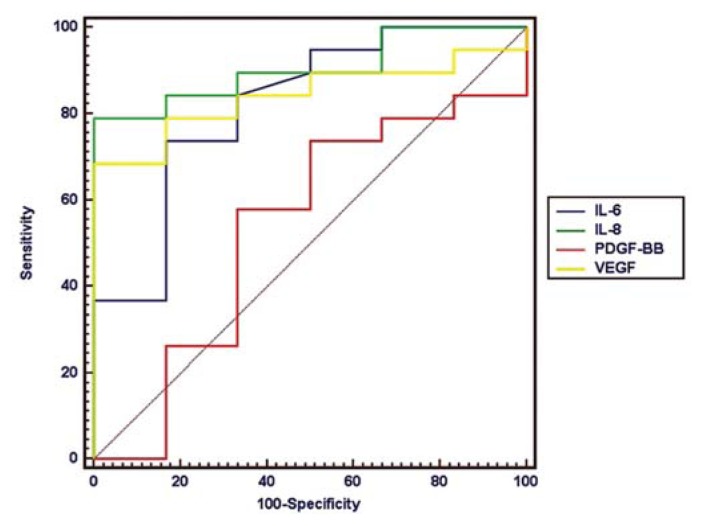
The diagnostic sensitivity and specificity of circulating angiogenic factors for HCC were assessed by receiver-operating characteristic (ROC) curves and the area under the ROC curve (AUR). The diagnostic performances of IL-8 (AUC, 0.865; sensitivity, 71%; specificity, 100%; cutoff value, 8.56 ng/L), VEGF (AUC, 0.842; sensitivity, 68%; specificity, 100%; cutoff value, 8.67 ng/L), and IL-6 (AUC, 0.79; sensitivity, 71%; specificity, 83%; cutoff value, 4.94 ng/L) in patients with HCC were better than chance (p < 0.01).